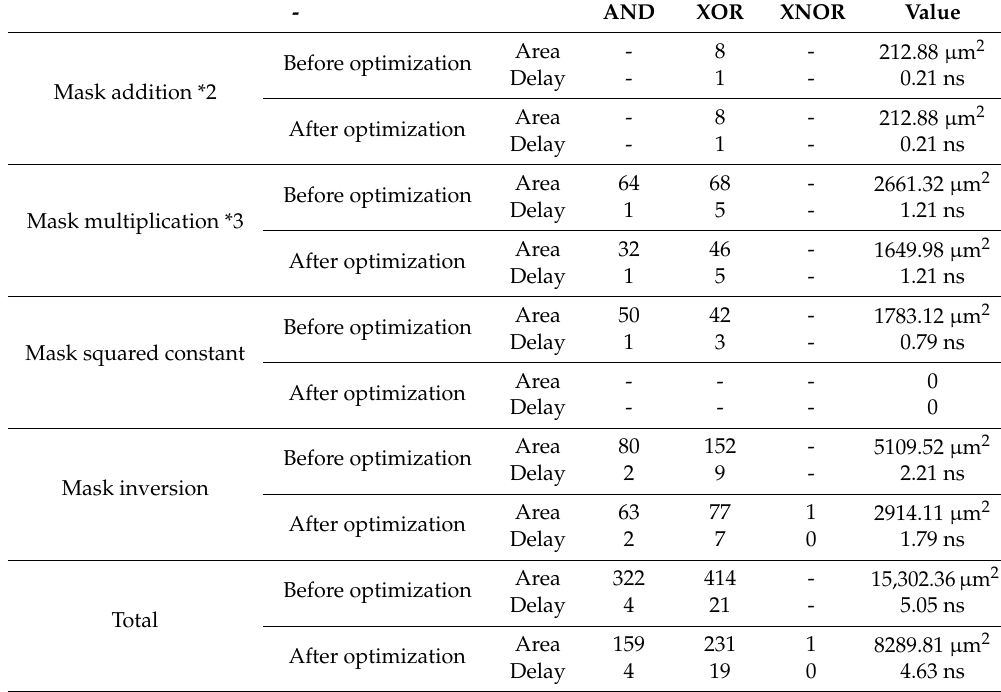
Table 1. Comparison of area and delay before and after optimization of mask GF ((2 4 ) 2 ) inversion.